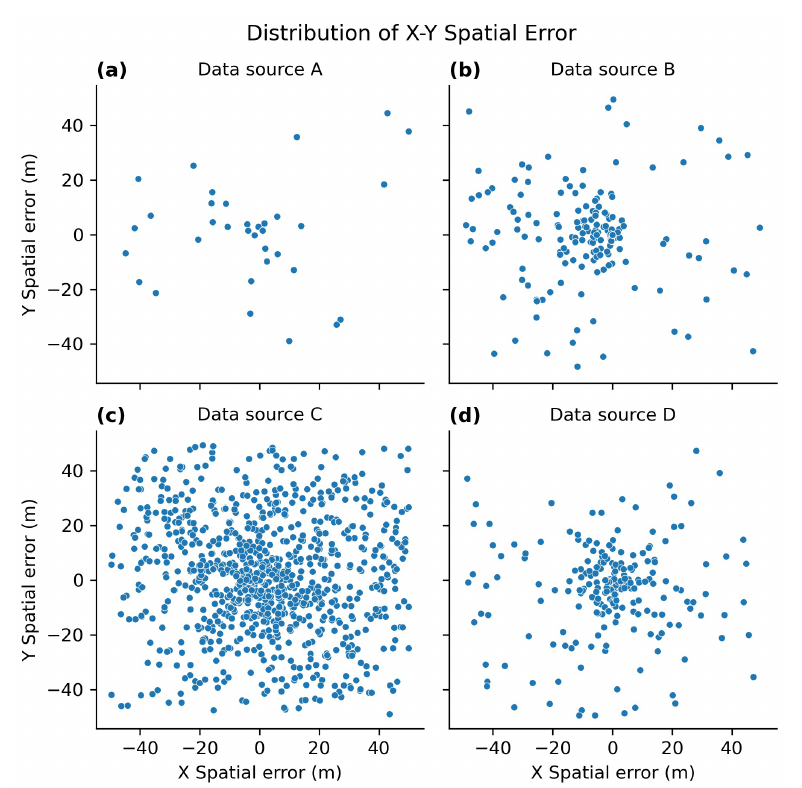
Figure 4. Distribution of spatial error in X (longitude) and Y (latitude) axes between corresponding points in D eval and D ref for the four data sources A to D ( a – d ).